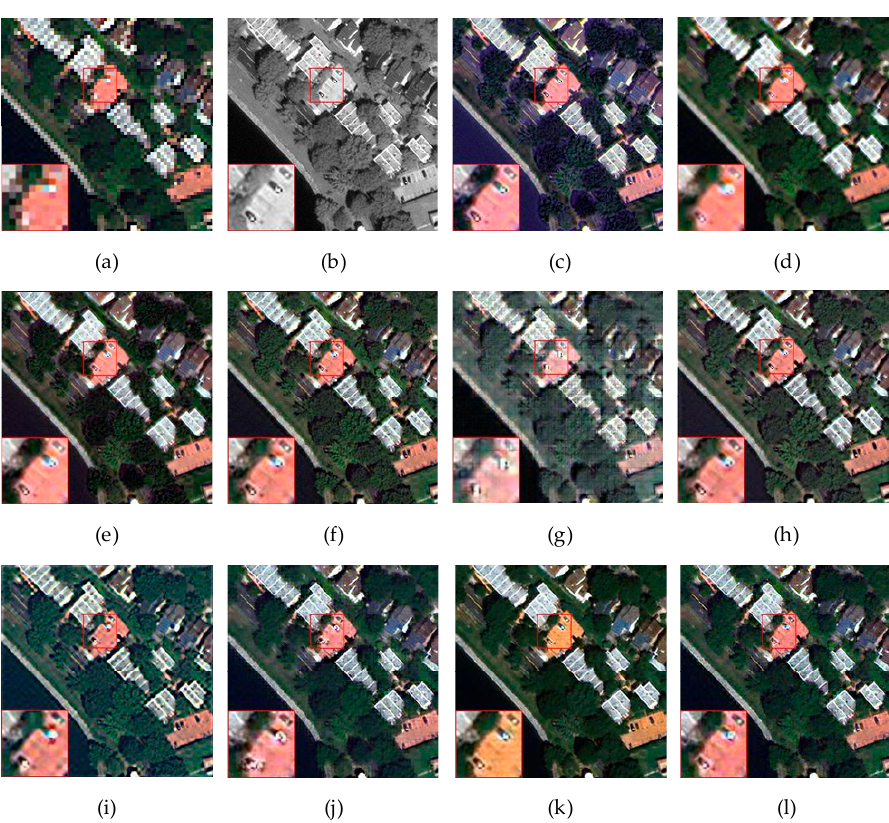
Figure 11. Results of the GeoEye ‐ 1 real dataset with four bands and 256 × 256 size. ( a ) Reference image; ( b ) PAN image; ( c ) IHS; ( d ) PRACS; ( e ) GS; ( f ) HPF; ( g ) DWT; ( h ) GLP; ( i ) SIRF; ( j ) PanNet; ( k ) PSGan; ( l ) MDECNN.